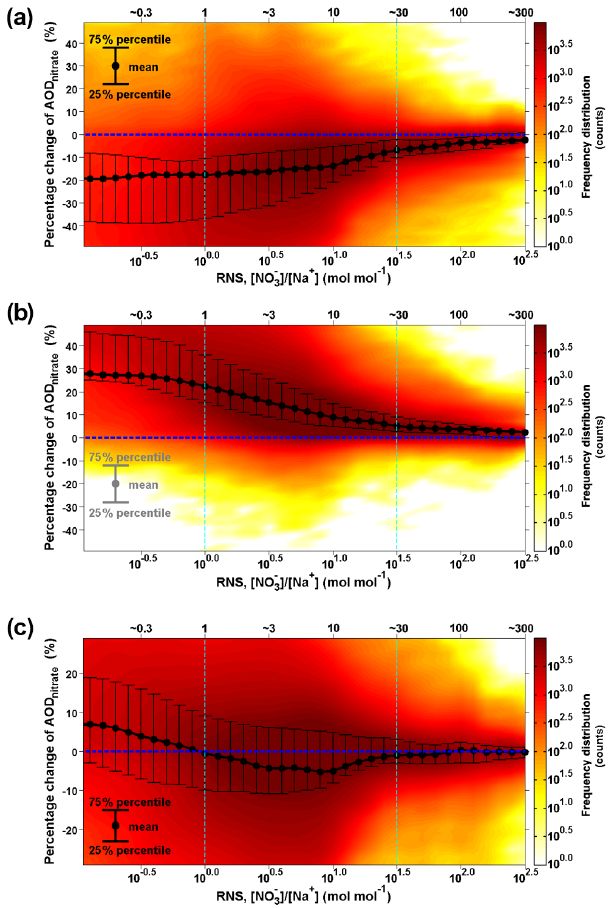
Figure 7. Intensity of the redistribution effect as a function of molar ratio between surface fine nitrate and total sodium (RNS) over the European domain. (a) The intensity of the redistribu- tion effect is calculated as the difference in percentage between AOD nitrate and AOD ∗ in Case_SeasaltOn; (b) the intensity of nitrate mass-enhancement effect. The black dots indicate the mean values; the upper and lower error bars indicate the 75th and 25th percentiles, respectively; (c) the net effect of mass-enhancement and redistribu- tion effects; the color indicates the frequency distribution (i.e., how many counts) of the hourly model results over the entire European domain during 16–20 September 2013. The coverage of model re- sults between the two dashed light-blue lines is ∼